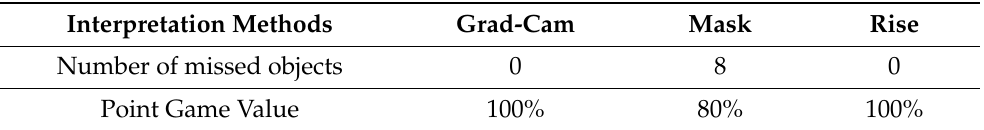
Figure 18. Failure cases of Mask method in panda category, goat category, school bus category and uniform category. (Note that these examples are from DataS.) Table 6. Point game statistics of three explanation methods on